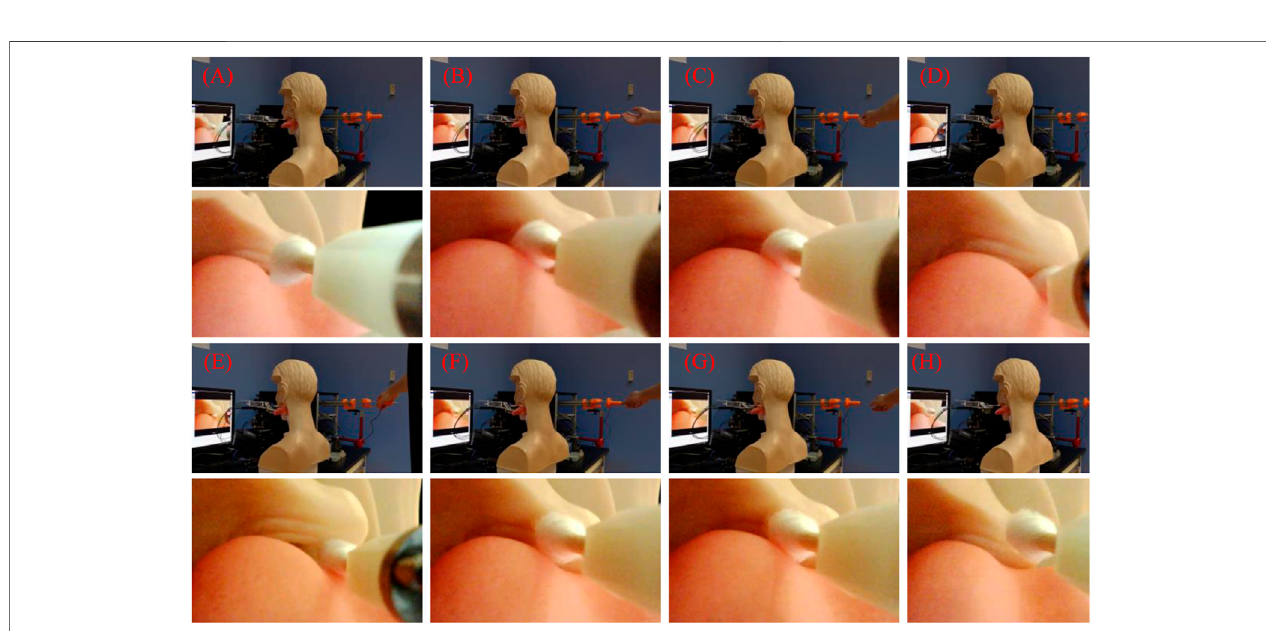
(cid:129) The human phantom was pushed forward with the tongue contact to the tongue depressor ( Figure 8B , time: 4 s). (cid:129) The tongue depressor was controlled to press the tongue ( Figure 8C , time: 3 s). (cid:129) The fl exible manipulator was controlled to reach the target region ( Figure 8D , time: 4 s). (cid:129) The fl exible manipulator was manipulated to get a sample via the swab stick ( Figure 8E , time: 6 s). (cid:129) The fl exible manipulator was controlled to retrieve from the throat ( Figure 8F , time: 6 s). (cid:129) The tongue depressor was retrieved ( Figure 8G , time: 2 s). (cid:129) The human phantom was pulled back ( Figure 8H , time: 6 s).